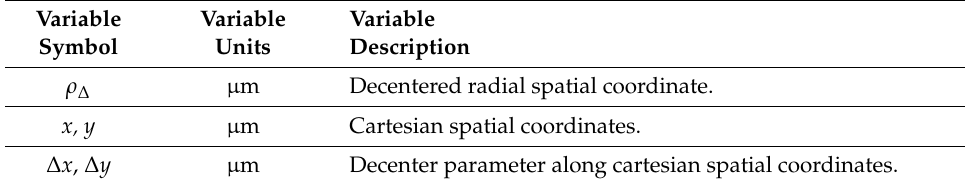
Table 4. In-Plane TM Variable Definitions.